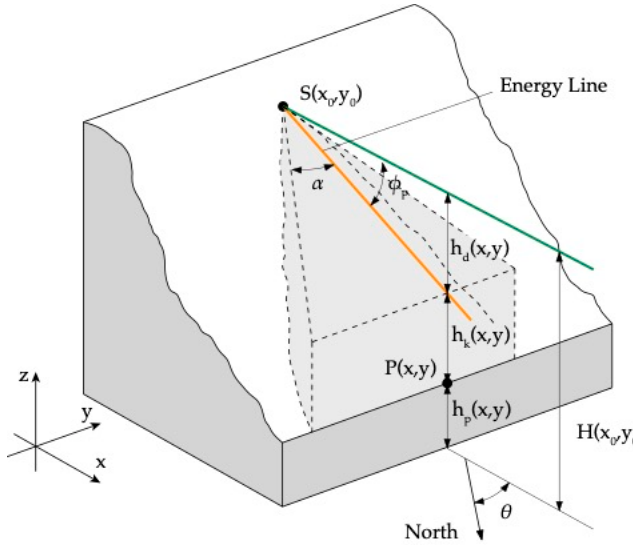
Figure 2. 3D sketch of the cone generation within the QPROTO plugin. The cone originates from the S(x 0 ,y 0 ) point and is sectioned by a vertical plane passing through the generic topographic point P ( x , y ). The light grey shows the volume of the cone, which is limited by the topographic surface and the plane defined by the energy line (orange line). The horizontal dark green line refers to the total energy of the block.